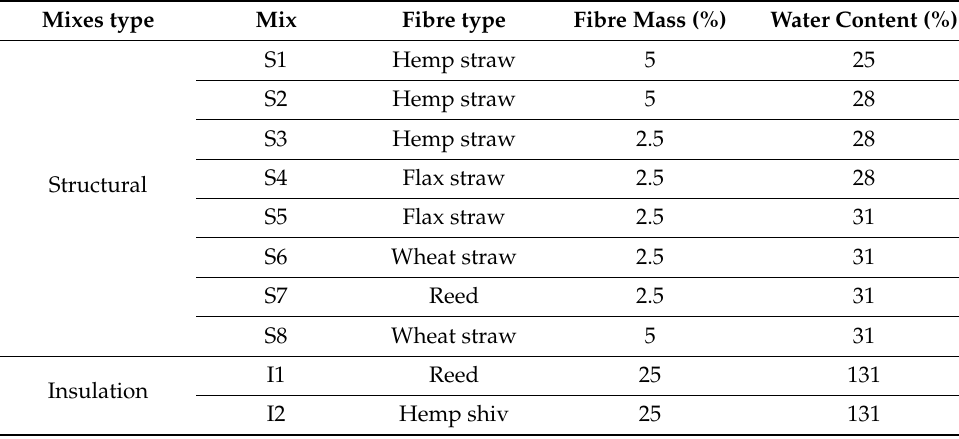
Table 1. The composition of structural and insulating cob mixtures